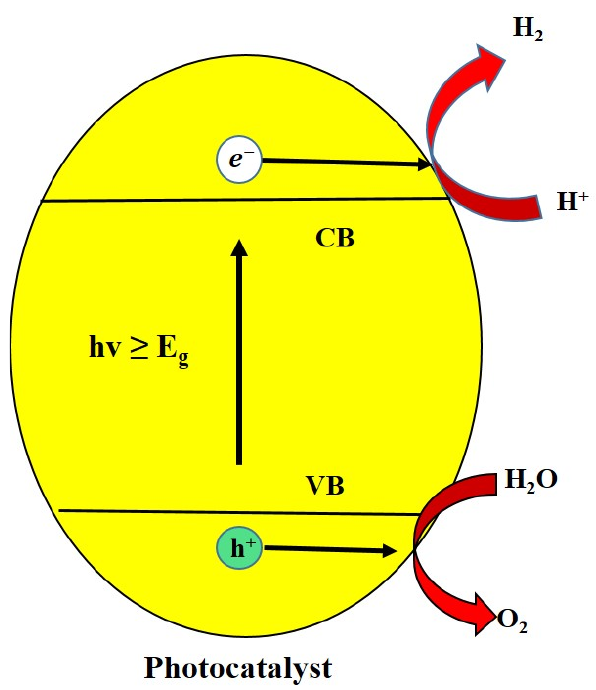
Catalysts 2023 , 13 , x FOR PEER REVIEW Figure 1. Mechanism of photocatalytic water splitting. Figure 1. Mechanism of photocatalytic water splitting.